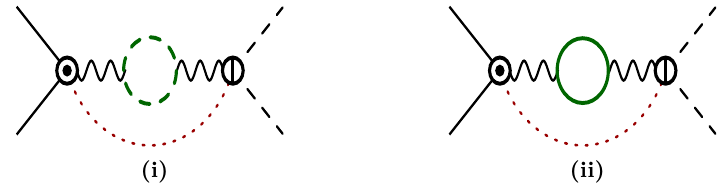
Figure 6 . One-loop diagrams built of Lorentz invariant renormalizable interactions of the UV theory that lead to effective operators of ψ 2 φ 2 D